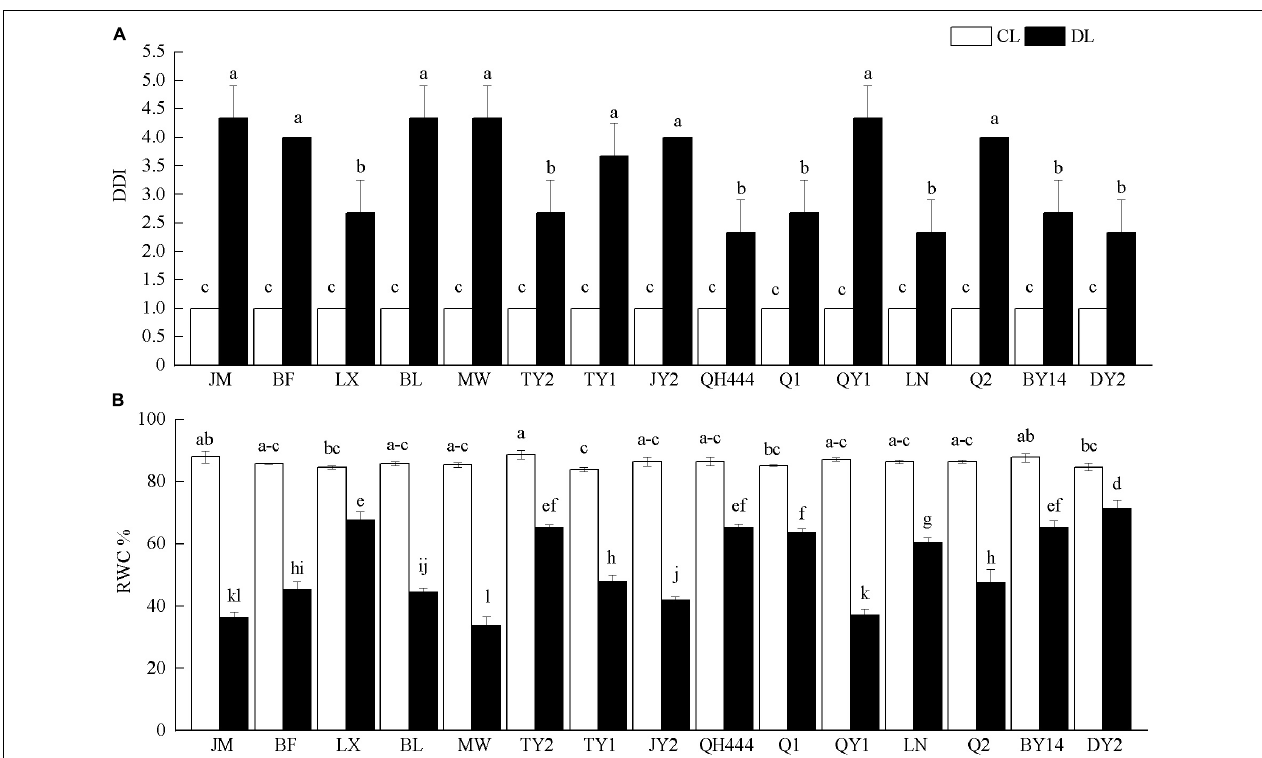
FIGURE 1 | Effects of drought stress on the drought damage index (DDI) (A) and relative water content (RWC%) content (B) in leaves of different oat varieties. Each value represents the mean ± SD. Each experiment was repeated three times. An analysis of variance test followed by a Tukey test was performed. CL, control; DL, drought stress. Different letters indicate that the differences between treatments were significant ( P <